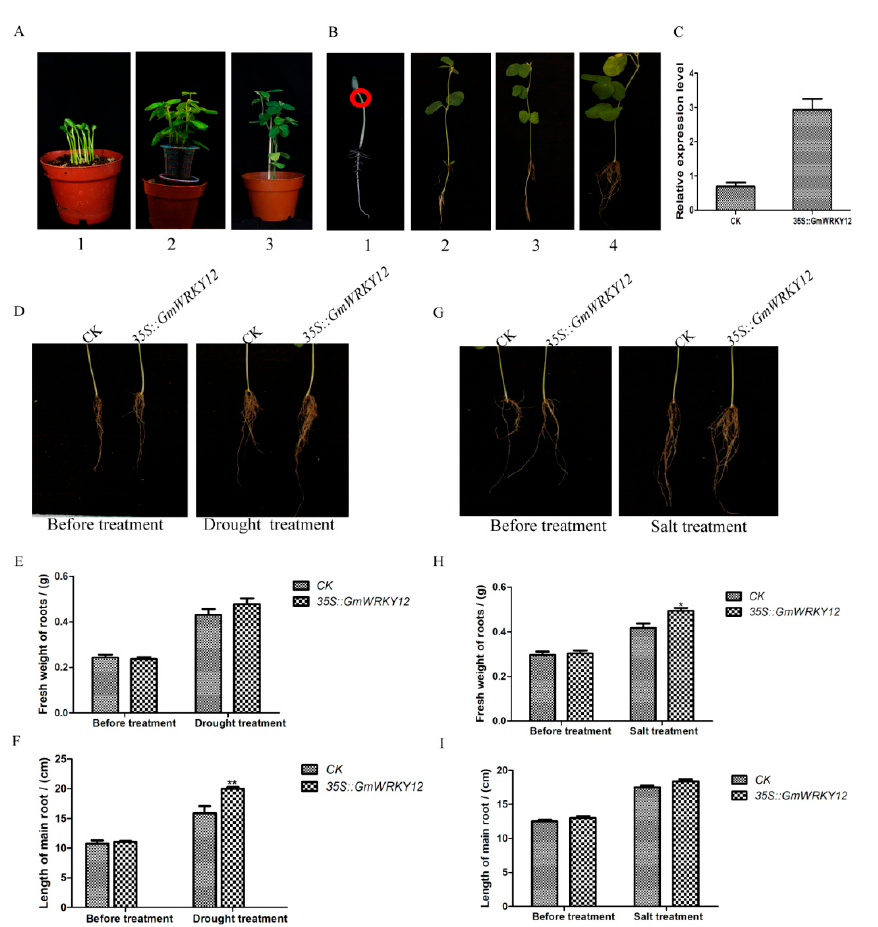
Figure 8. Different growth stage of transgenic soybean seedlings and phenotypes of transgenic soybean hair roots. ( A ) Images of different growth stage of transgenic soybean seedlings cultivated in flowerpot before any treatment. ( A1 ) Soybean seedlings of 5-days-old without injected A. rhizogenes carrying GmWRKY12 . ( A2 ) Soybean seedlings which have injected A. rhizogenes carrying GmWRKY12 for 7 days. ( A3 ) Soybean seedlings which have injected A. rhizogenes carrying GmWRKY12 for 14 days (The original main roots were removed by cutting from 1 cm below the infection site and the hairy roots of the seedlings were cultivated in nutritious soil with full water and grown with 16 h light (100 µ M photons m − 2 ·s − 1 )/8 h dark at 25 °C). ( B ) Images of different growth stage of signal transgenic soybean seedling before any treatment. ( B1 ) Soybean seedling of 5-days-old without injected A. rhizogenes carrying GmWRKY12 and the red circle shows the inject site of A. rhizogenes. ( B2 ) Soybean seedling which have injected A. rhizogenes carrying GmWRKY12 for 7 days and new hair roots have generated. (B 3 ) Soybean seedling which have injected A. rhizogenes carrying GmWRKY12 for 14 days. (B 4 ) Soybean seedling that have salt treatment for 7days. ( C ) Relative expression of CK and 35S::GmWRKY12 transgenic soybean hair roots under normal growth conditions. ( D ) Images of drought stress resistance phenotypes of CK and 35S::GmWRKY12 transgenic soybean hair roots after drought treatment for 20 days. ( E ) Fresh weight in CK and 35S::GmWRKY12 transgenic soybean hair roots under normal growth conditions and drought treatment. ( F ) Length in CK and 35S::GmWRKY12 transgenic soybean hair roots under normal growth conditions and drought treatment. ( G ) Images of salt stress resistance phenotypes of CK and 35S::GmWRKY12 transgenic soybean hair roots after 200 mM NaCl treatment for 7 days. ( H ) Fresh weight in CK and 35S::GmWRKY12 transgenic soybean hair roots under normal growth conditions and salt treatment. ( I ) Length in CK and 35S::GmWRKY12 transgenic soybean hair roots under normal growth condition and salt treatment. All data represent the means ± SDs of three independent biological replicates. ANOVA tests demonstrated that there were significant differences (* p < 0.05, ** p < 0.01).